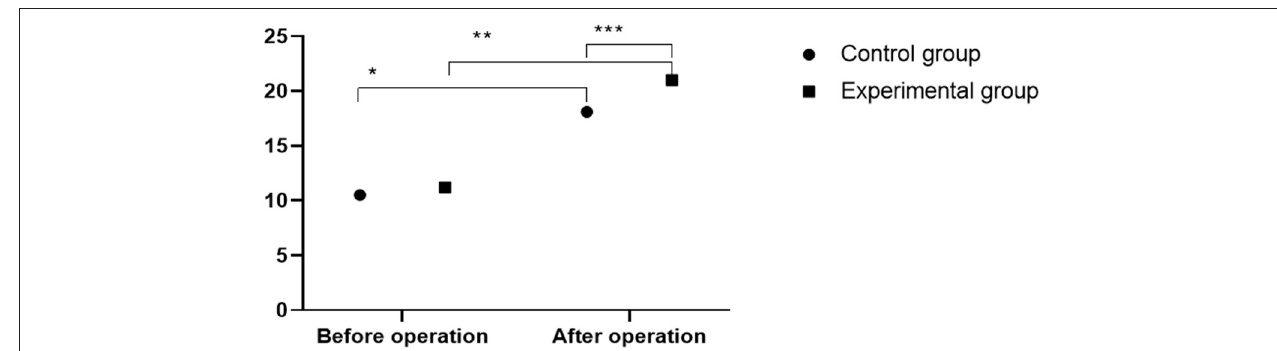
FIGURE 2 | Comparison of anterior height of vertebral body between two groups ( x ± s). The abscissa indicates preoperation and postoperation, and the ordinate indicates the height of the anterior edge of the vertebral body (mm). The height of anterior vertebral body before and after operation in control group was (10.5 ± 5.1) mm and (18.1 ± 2.4) mm, respectively. The height of anterior vertebral body before and after operation in experimental group was (11.2 ± 4.7) mm and (21.0 ± 6.4) mm, respectively. * indicates the height of anterior vertebral body before and after operation in the control group was significantly different ( t = 11.0368, P < 0.01); ** indicates the height of anterior vertebral body before and after operation in the experimental group was significantly different ( t = 10.2520, P < 0.01); *** indicates there was significant difference in the height of anterior vertebral body between two groups ( t = 3.5242, P = 0.0006).